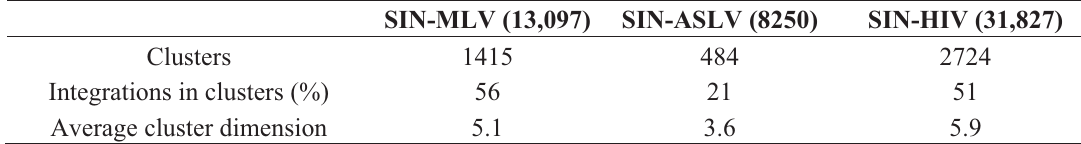
Table 3. Clusters of integration sites in the genome of human